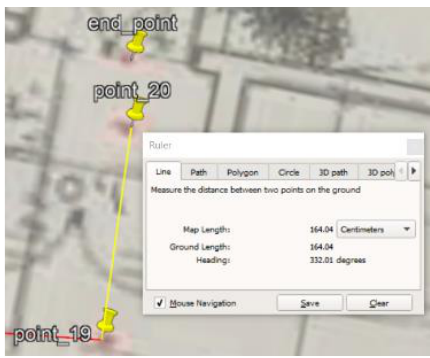
Figure 32. Length and heading to point_20.